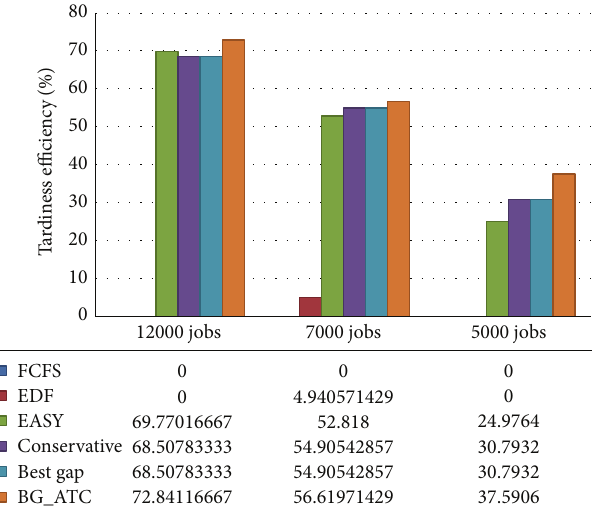
Figure 5: Tardiness analysis on blue workload.